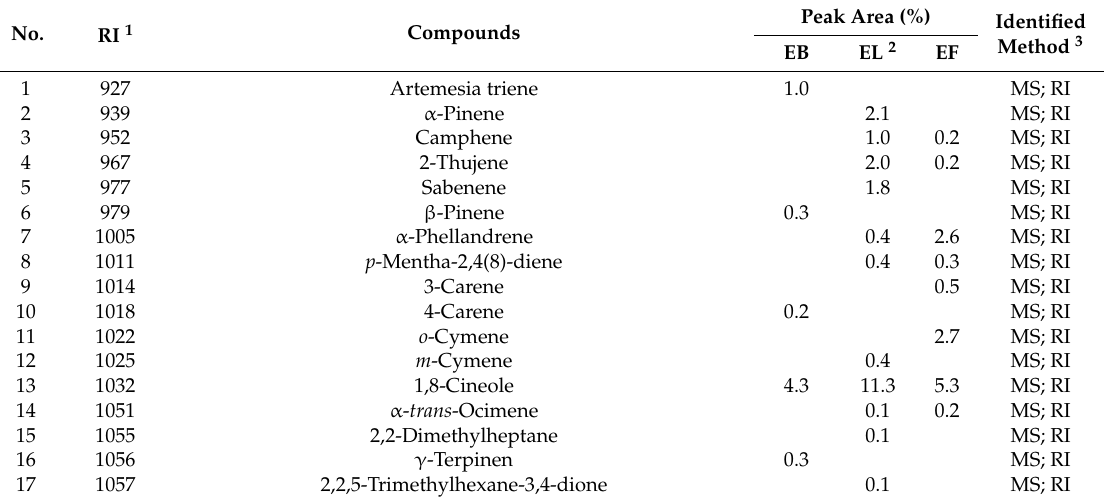
Table 1. Constituents identified from the essential oils of barks (EB), leaves (EL), and fruits (EF) of Cinnamomum camphora